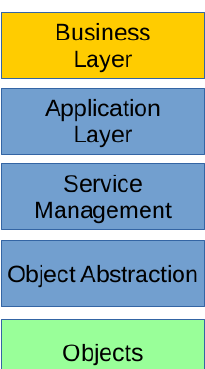
Figure 2. Five-layer IoT architecture (adapted from Al-Fuqaha et al., 2015